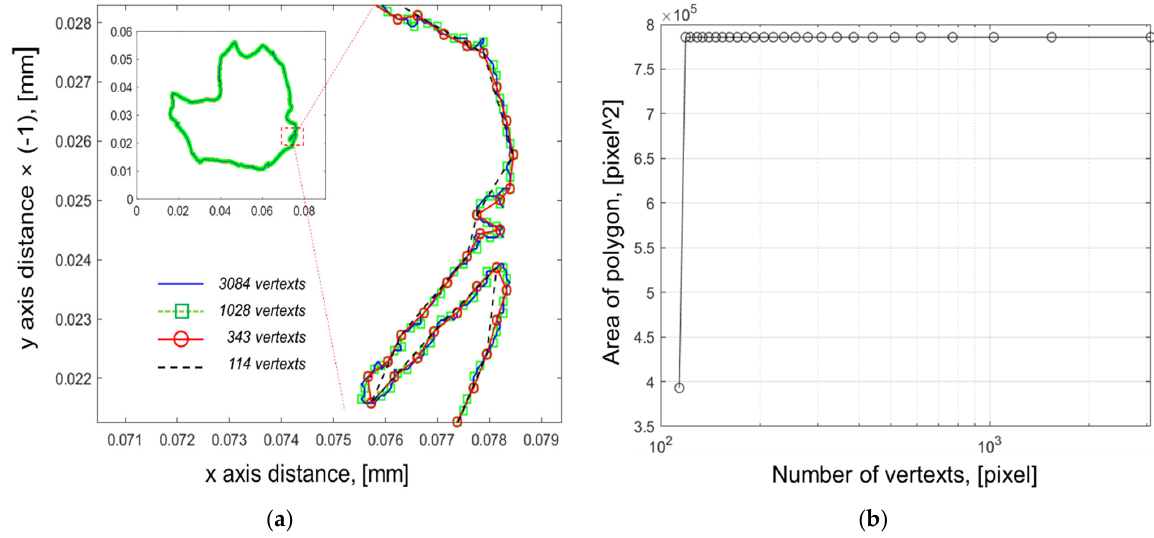
Figure 6. Changes of shape and area due to reducing the number of nodes which consists of the boundary. ( a ) Shape changes; ( b ) Area changes.